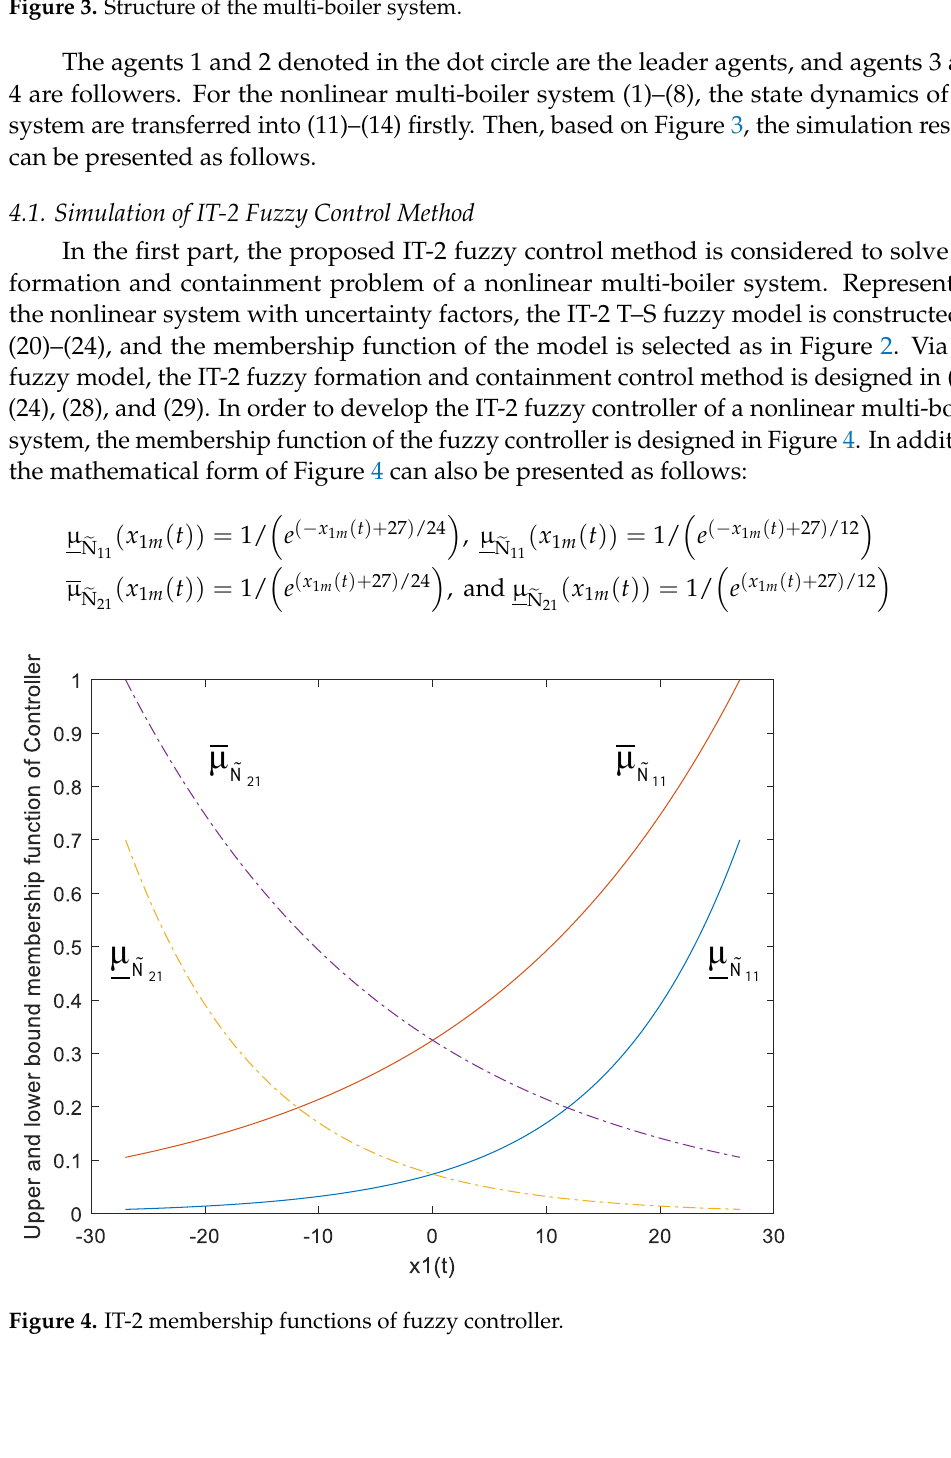
Figure 4. IT-2 membership functions of fuzzy controller.